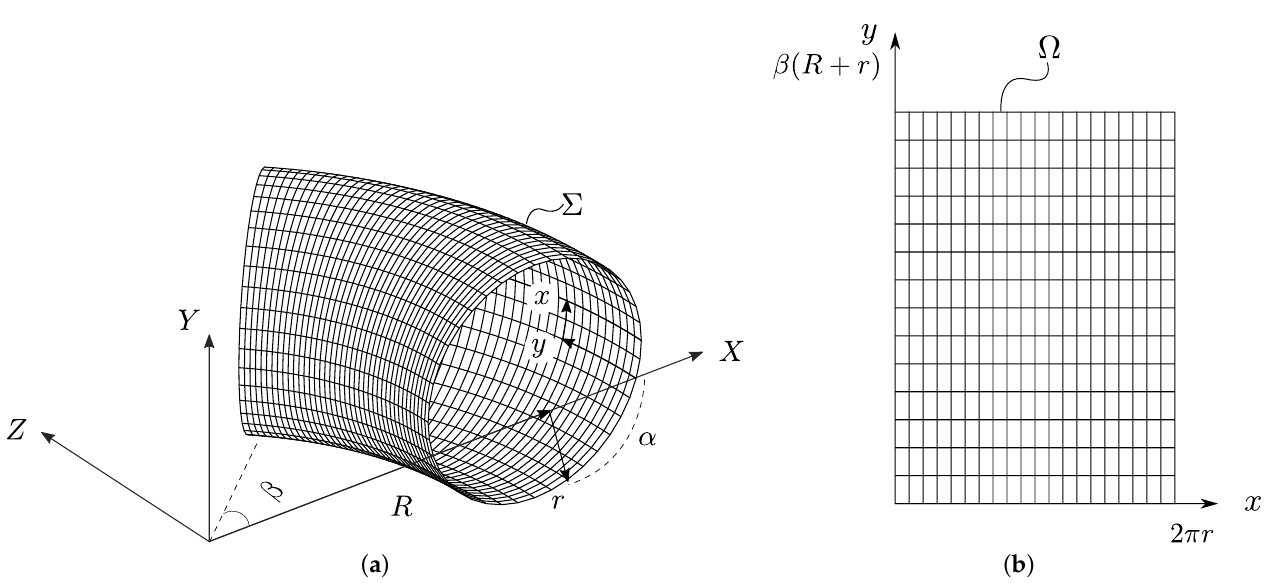
Figure 2. A torus section representing the bend of a pipe is translated from ( a ) the 3D space domain Σ to ( b ) the 2D space domain Ω